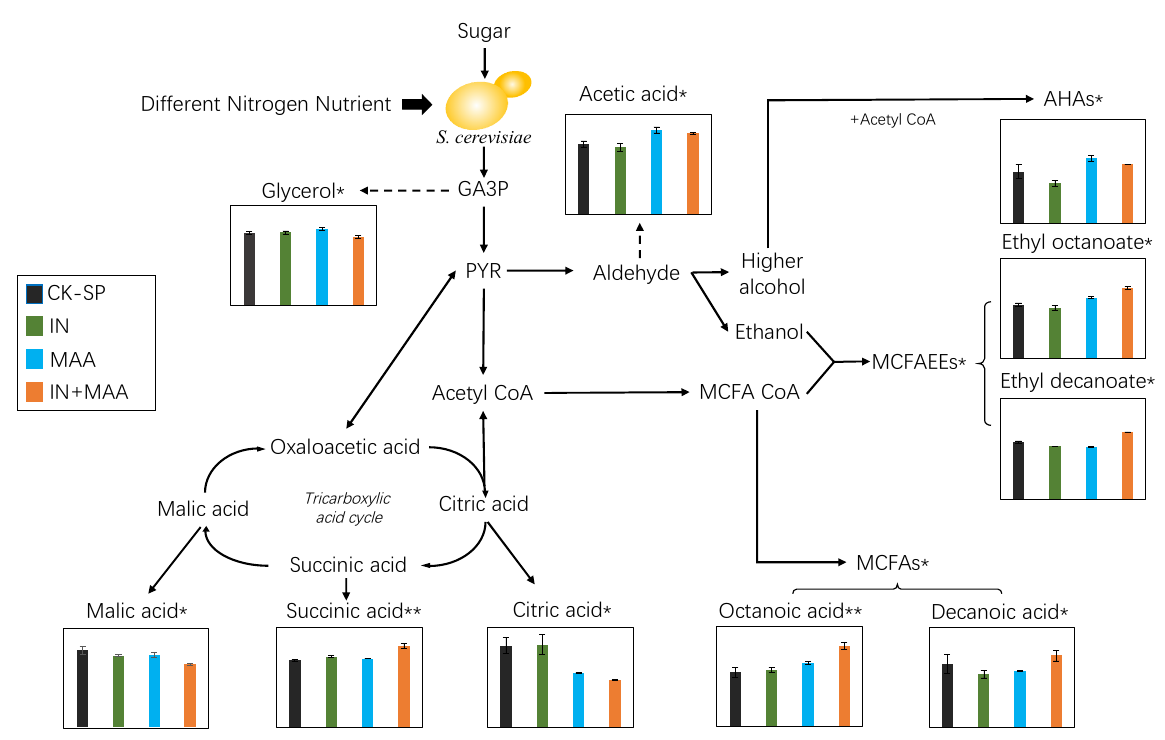
Figure 3. Redistribution of carbon fluxes in the central metabolic network by different nitrogen treatments. PYR, pyruvate; GA3P, glyceraldehyde 3-phosphate; ACTA, acetaldehyde. Data are mean ± standard deviation. Differences are significant at 95% (*), 99% (**)confidence level. AHA, acetate of higher alcohol; MCFA, medium-chain fatty acid; MCFAEE, medium-chain fatty acid ethyl ester; CK-SP, spine grape control; IN, DAP supplement; MAA, mixed nitrogen supplement with alanine, phenylalanine, and isoleucine; IN+MAA, mixed nitrogen supplement with DAP, alanine, phenylalanine, and isoleucine.